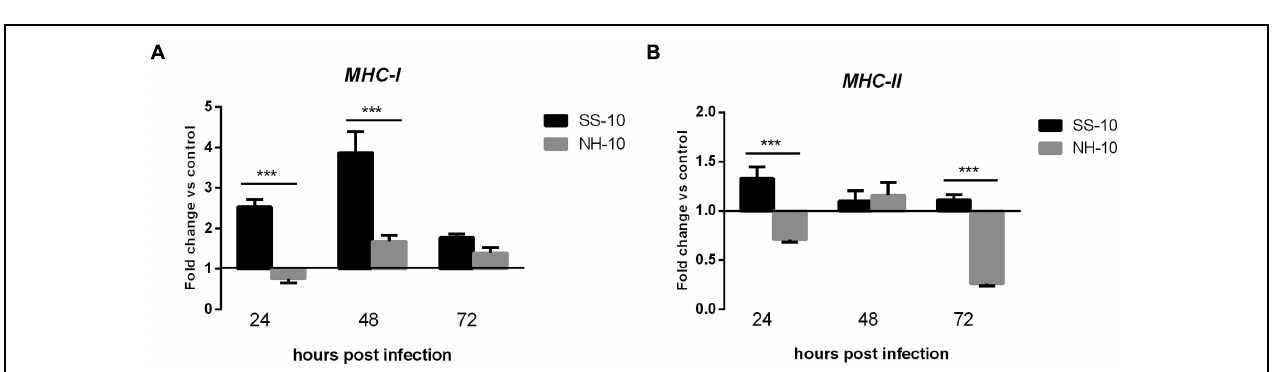
FIGURE 6 | Fold change expression of MHC in the lungs of infected ducks in response to SS-10 and NH-10. (A) MHC-I , (B) MHC-II . The Y -axis represents the fold change in target gene expression in the experimental group relative to those in the control group and presented as the mean values ± standard deviation ( n = 3). Significance is analyzed with two-way ANOVAs between SS-10 group and NH-10 group at the same time points ( ∗ p < 0.05, ∗∗ p < 0.01, ∗∗∗ p < 0.001). Error bars indicate standard deviations.